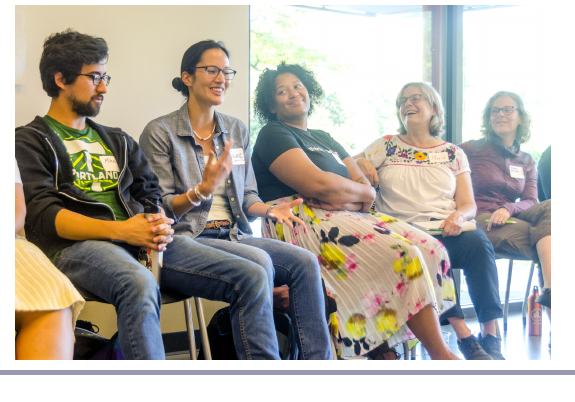
Fig. 3 . Small groups of Learning from Place workshop participants discuss origin stories.